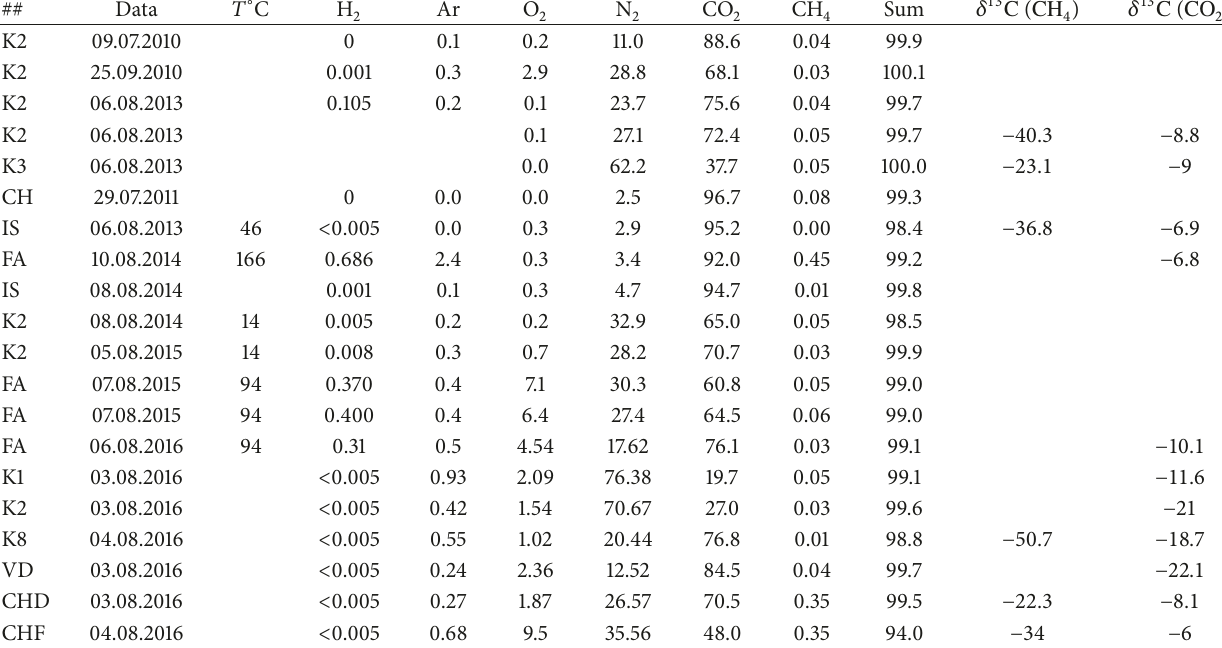
(b) Gas chemistry (vol % ) and carbon isotopic data of hot and cold springs of the Koryaksky-Avachinsky volcanogenic basin, according to sampling data collected from 2011–2016; ##, denoted names, see Table 1 for explanation. Sampling was performed by A. Kiryukhin, T. Rychkova, and V. Lavrushin. Chemical analyses were performed in the Central Chemistry Lab (Guseva V. I.). Isotopic analyses ( 𝛿 13 C) were performed by B. G.